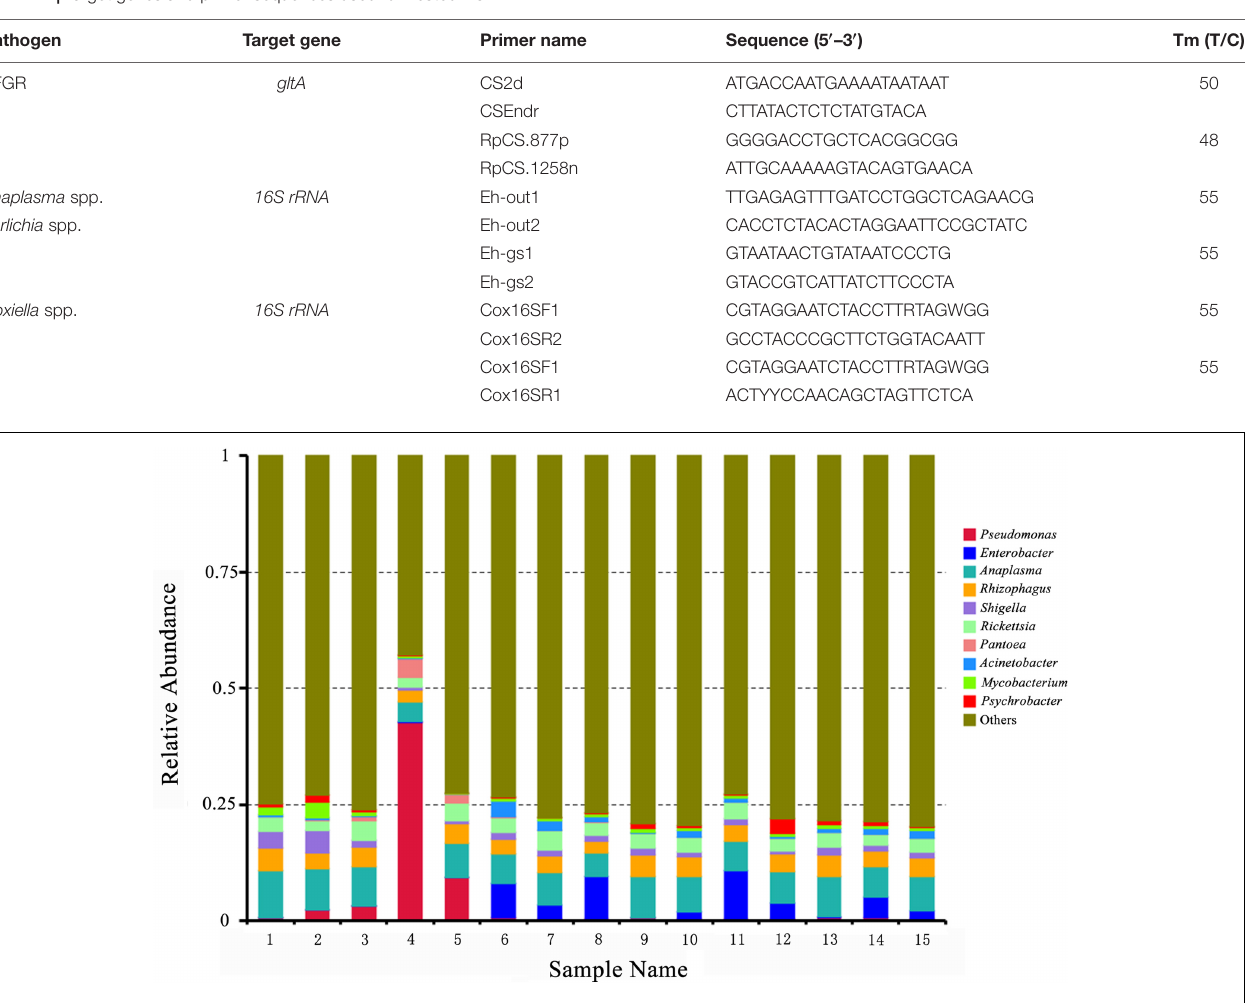
FIGURE 2 | Relative abundances of potential top 10 pathogens at the genus level in pooled Rhipicephalus microplus samples. The x -axis indicates pooled DNA sample names of Rh. microplus for metagenomic next-generation sequencing; the y -axis indicates relative abundance. “Others” indicates the sum of the relative abundance of all genera except the top